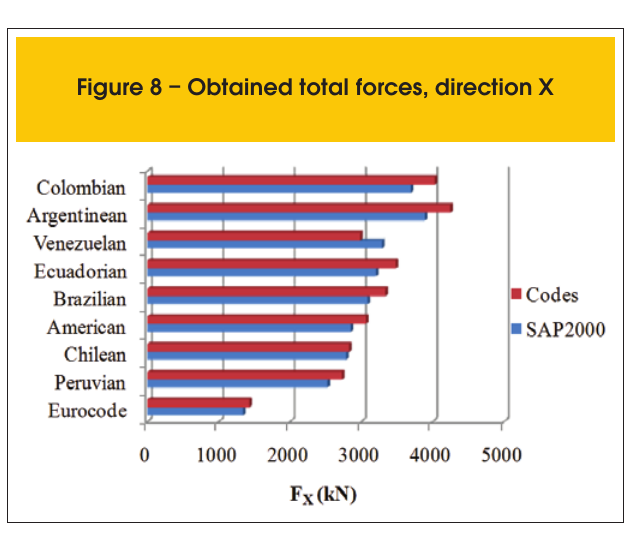
Figure 9 – Obtained total forces, direction